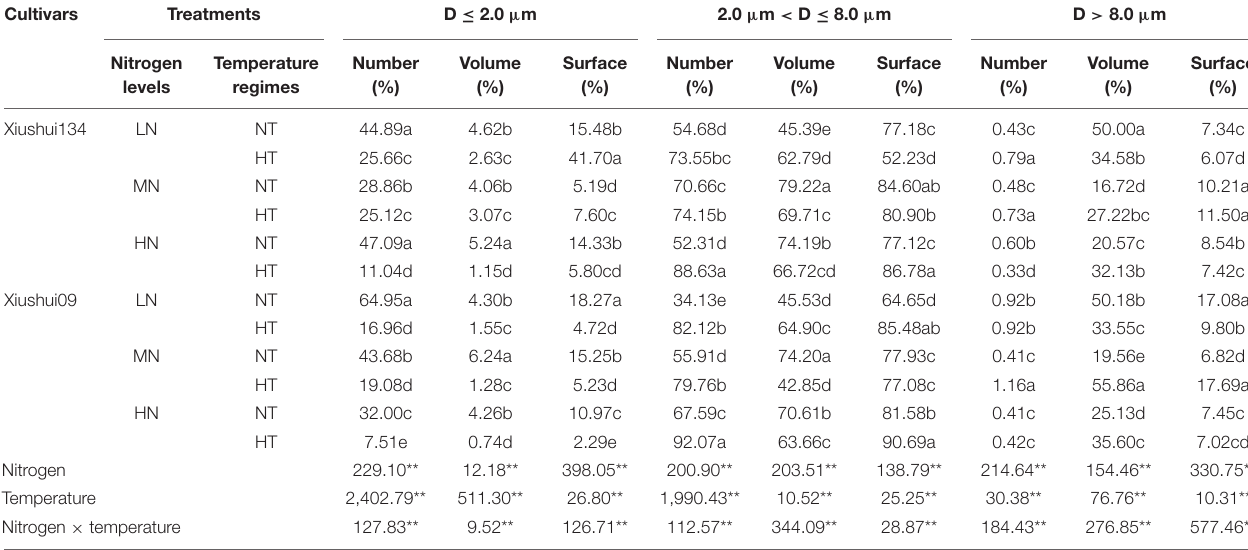
TABLE 2 | Difference in starch granule distribution (by number-, volume-, and surface-based percentages) among different treatments. Cultivars